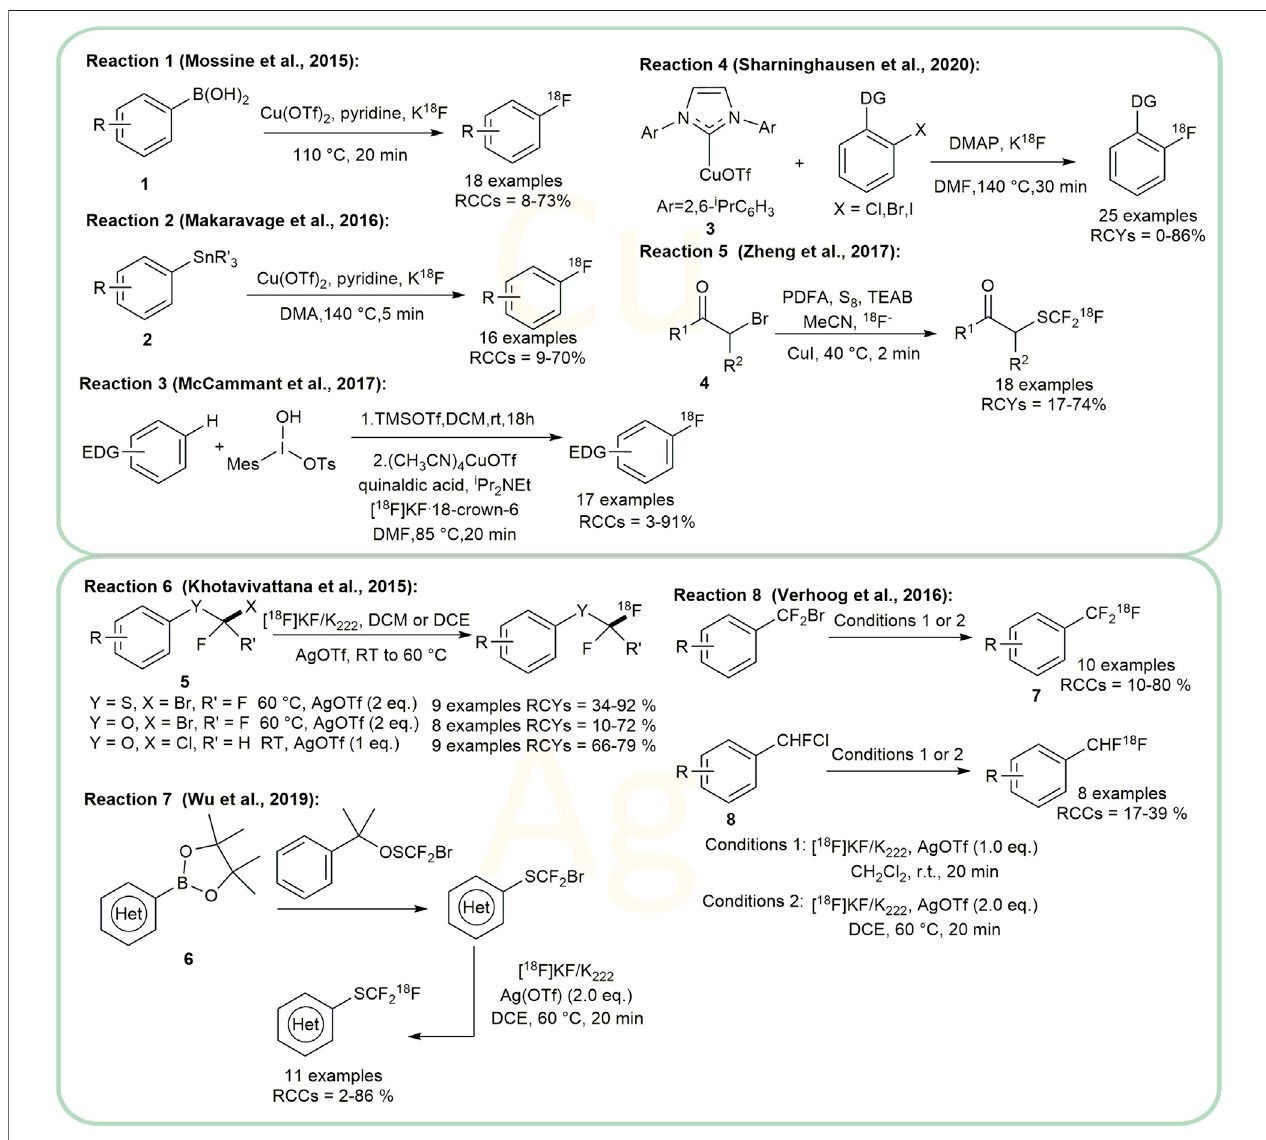
FIGURE 2 | Cu and Ag mediated/catalyzed radio fl